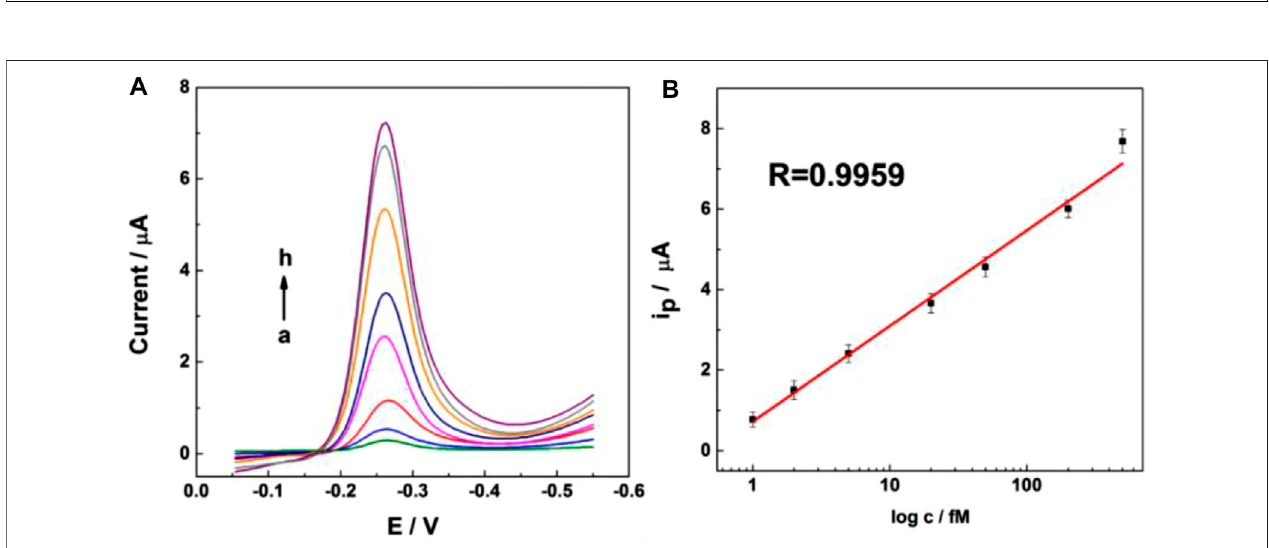
Frontiers in Bioengineering and Biotechnology |